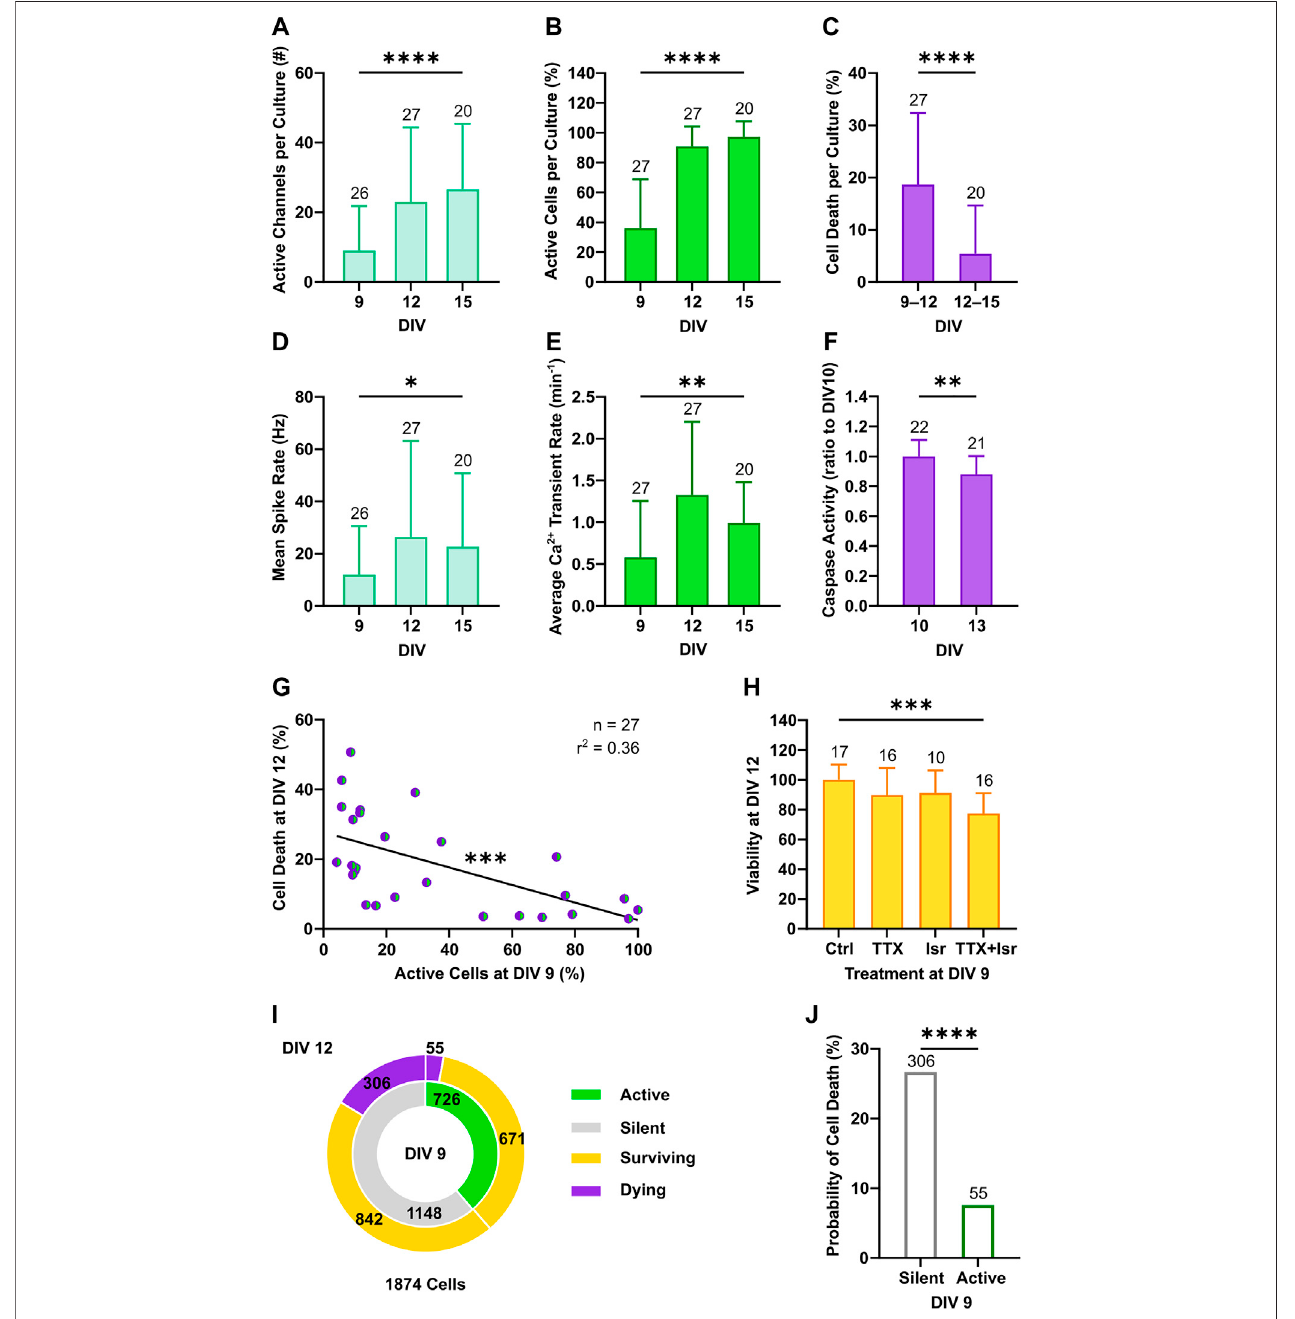
FIGURE 2 | Neuronal activity decreases the probability of programmed cell death. (A – C) The number of active channels and the relative proportion of active neuronsincreasedwithdevelopment(Kruskal-Wallistest),whereasthepercentageofcelldeathdetectedthroughlongitudinalnls-dTomatoimagingdecreasedfromDIV 9 – 12 to DIV 12 – 15 (Mann-Whitney test). (D,E) The mean spike rate per culture recorded with MEA and the average rate of detected calcium transients increased from DIV9toDIV12andthenstabilized(Kruskal-Wallistest). (F) Inlinewiththeobservedratesofcelldeath,caspaseactivityincultureswashigheratDIV10comparedto DIV 13 (Student unpaired t -test). (G) The proportion of active neurons in cultures at DIV 9 negatively correlated with the subsequent cell death rate at DIV 12 (F test). (H) Viability of culture at DIV 12 was reduced by combined application of tetrodotoxin (TTX) and isradipine (Isr) (Kruskal-Wallis test, followed by Dunnett ’ s multiple comparisonstest, p < 0.0001),whereasapplicationofTTXonlyledtoaslightandnon-signi fi cantreductioninviability. (I) Therelativeproportionofneuronswithasurvival cell fate was higher among active neurons as compared to the silent population. (J) On the single neuron level, the probability of cell death was higher in neurons, which were silent at DIV 9 as compared to active neurons (Chi-square test). Bar charts with mean ± SD or scatter plots with line indicating simple linear regression are shown. * p < 0.05, ** p < 0.01, *** p < 0.001 and **** p < 0.0001.